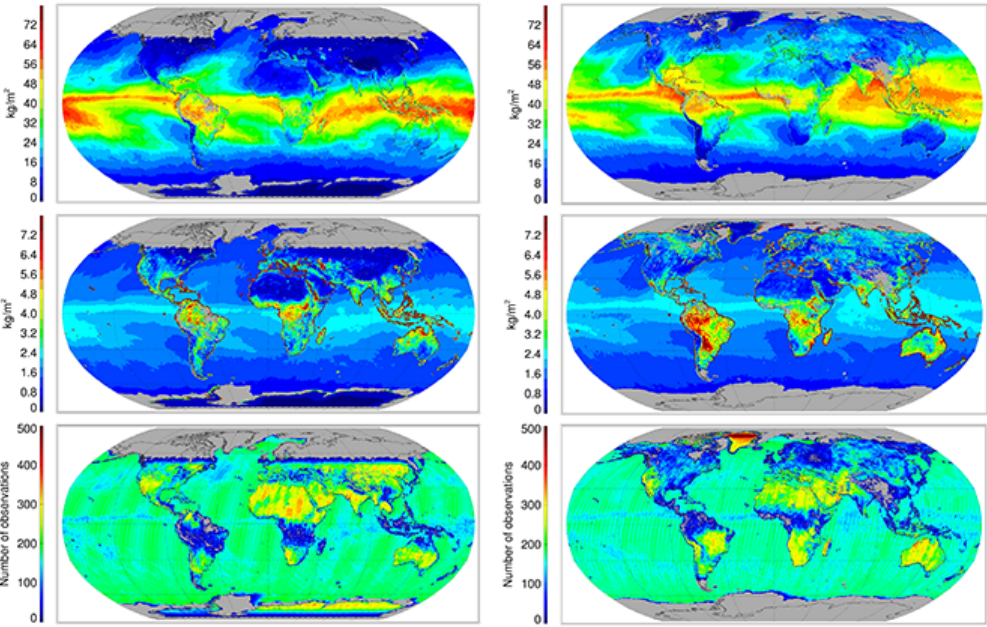
Figure 3. Monthly mean TCWV (top), associated uncertainty (middle) and number of observations used (bottom) for January (left) and June (right) 2003.